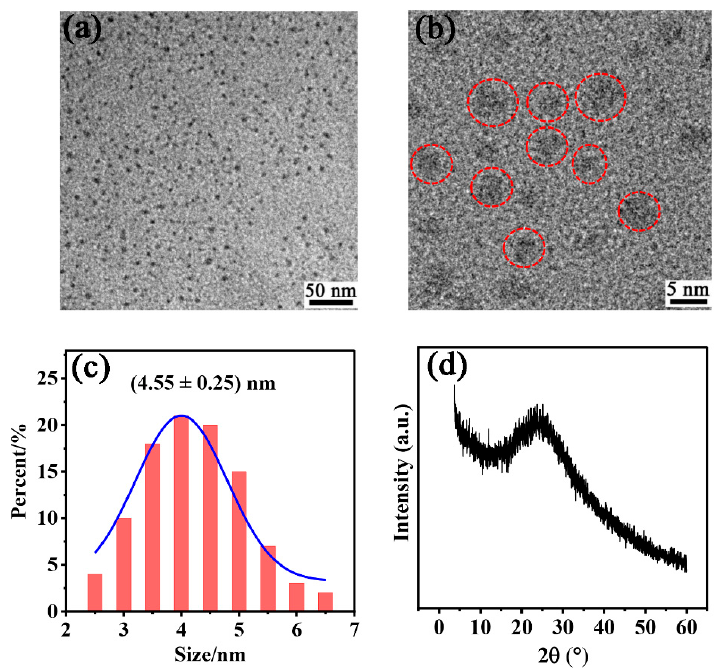
Figure 1. TEM images ( a , b ), size distribution ( c ) and XRD pattern ( d ) of the as-fabricated NCDs. The red circles in ( b ) denote the HRTEM images of NCDs.